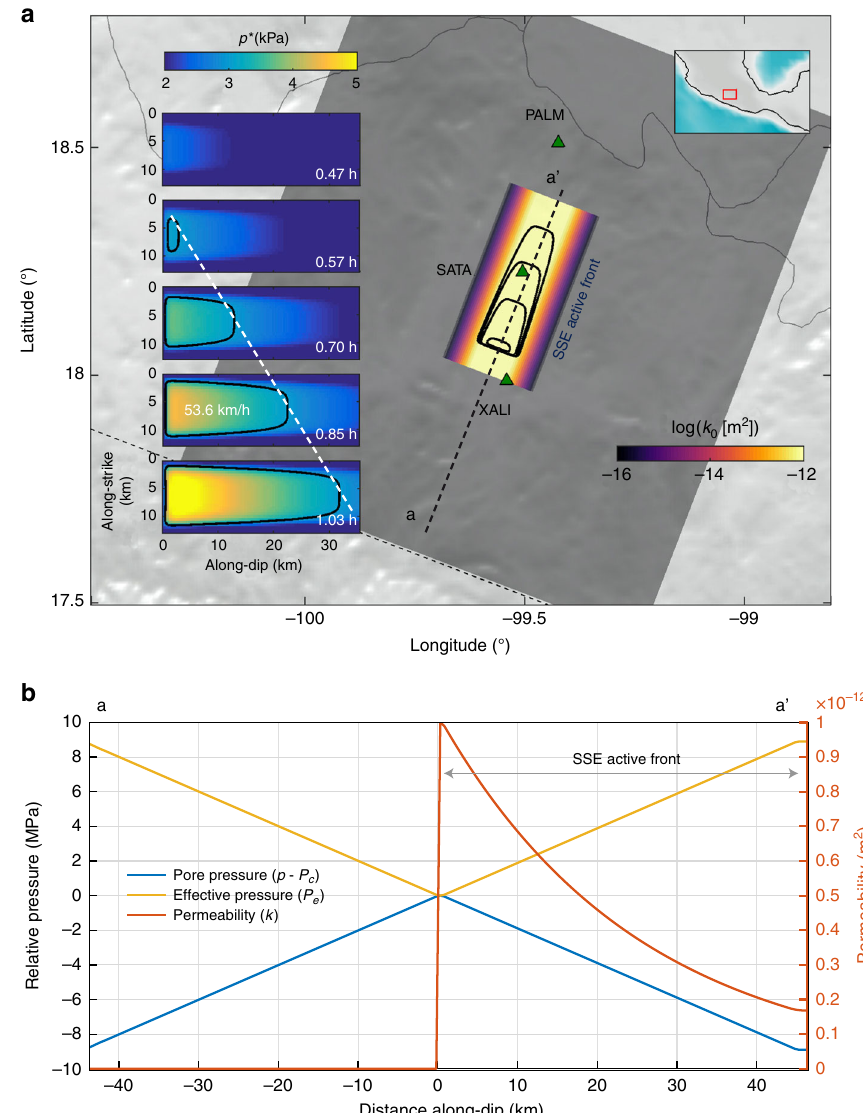
Fig. 6 Two-dimensional pore-pressure wave simulation in Guerrero. In this model, permeability k 0 gradually increases (black – yellow shade in panel a ) inside an elongated trench-perpendicular region that we assume corresponds to the most active SSE front (i.e., where slip-rate is signi fi cantly large). The blue-yellow shade in panel a shows the evolution of pore pressure (where p * = p − p ), while the black contours indicate the position of the wave-front for a pressure threshold of 3 kPa. Compare with Fig. 3. Panel b shows the initial conditions for the simulation along the cross-section a – a ′ depicted with a dashed black line in panel a . The basemap was created using SRTM15 +